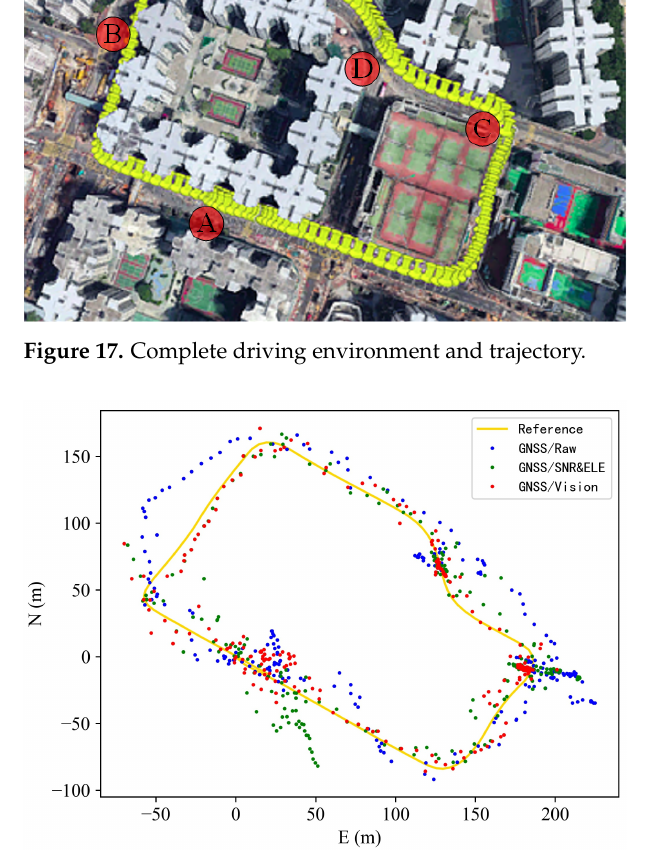
Figure 18. Positioning results in three